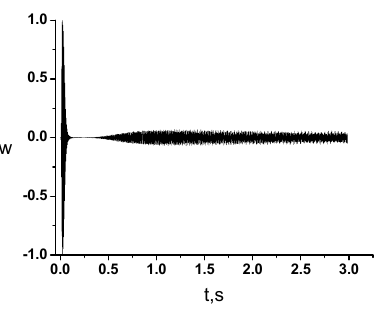
Figure 1. The oscillations inside the initial cylinder.